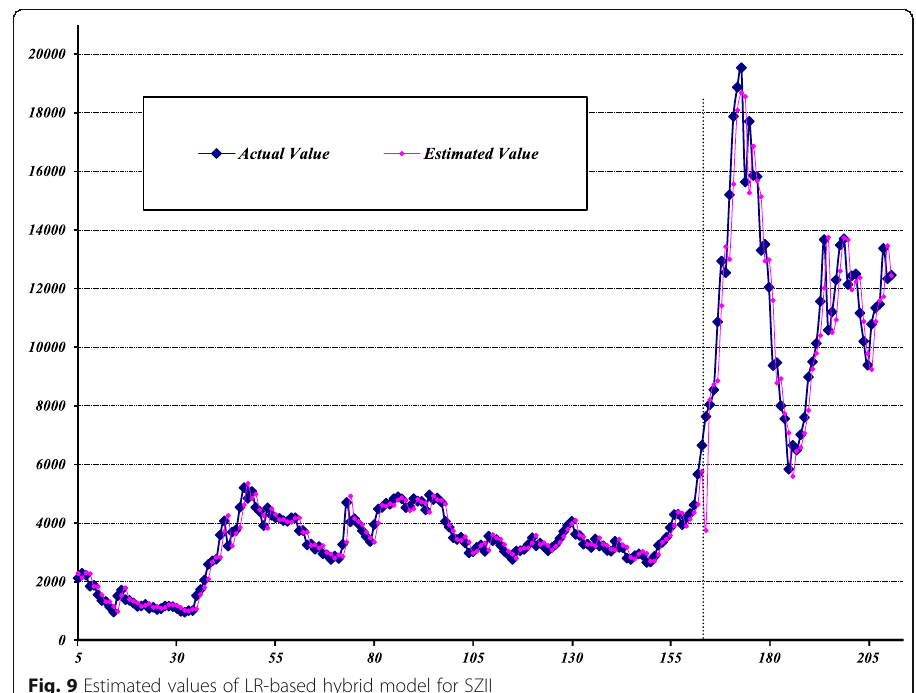
Fig. 9 Estimated values of LR-based hybrid model for